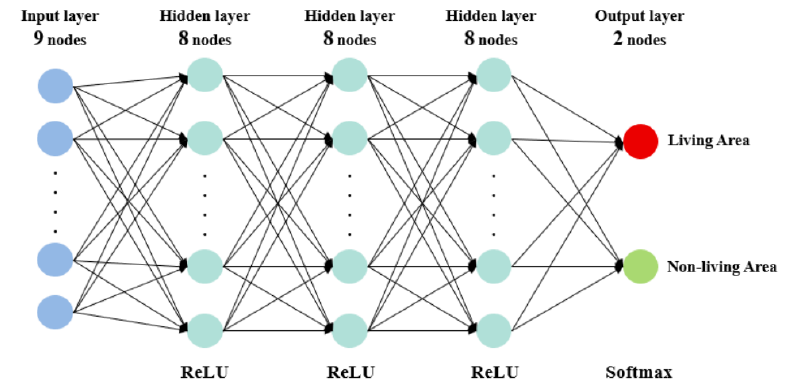
Figure 11. Architecture of Deep Neural Network (DNN). Figure 12 is an example of the pre-processed protrusion map directly used for DNN training. For each indoor environment, DNN prediction results are accumulated for every 500 detection from 10,000 human detection data (for the estimation of temporal change in the living area of residents). When accumulating previous and current predictions, following time weighted function is applied.